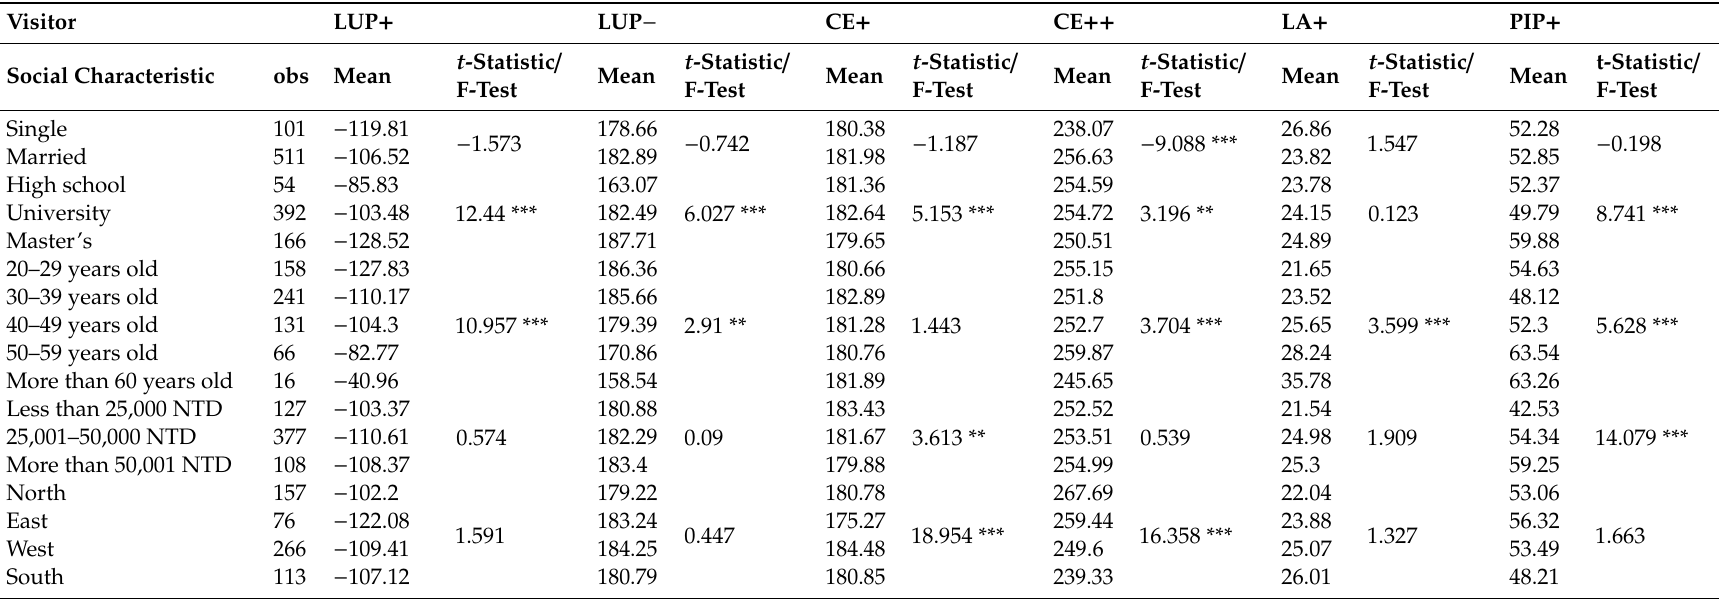
Table 5. Cross-analysis of tourist socioeconomic background and environment